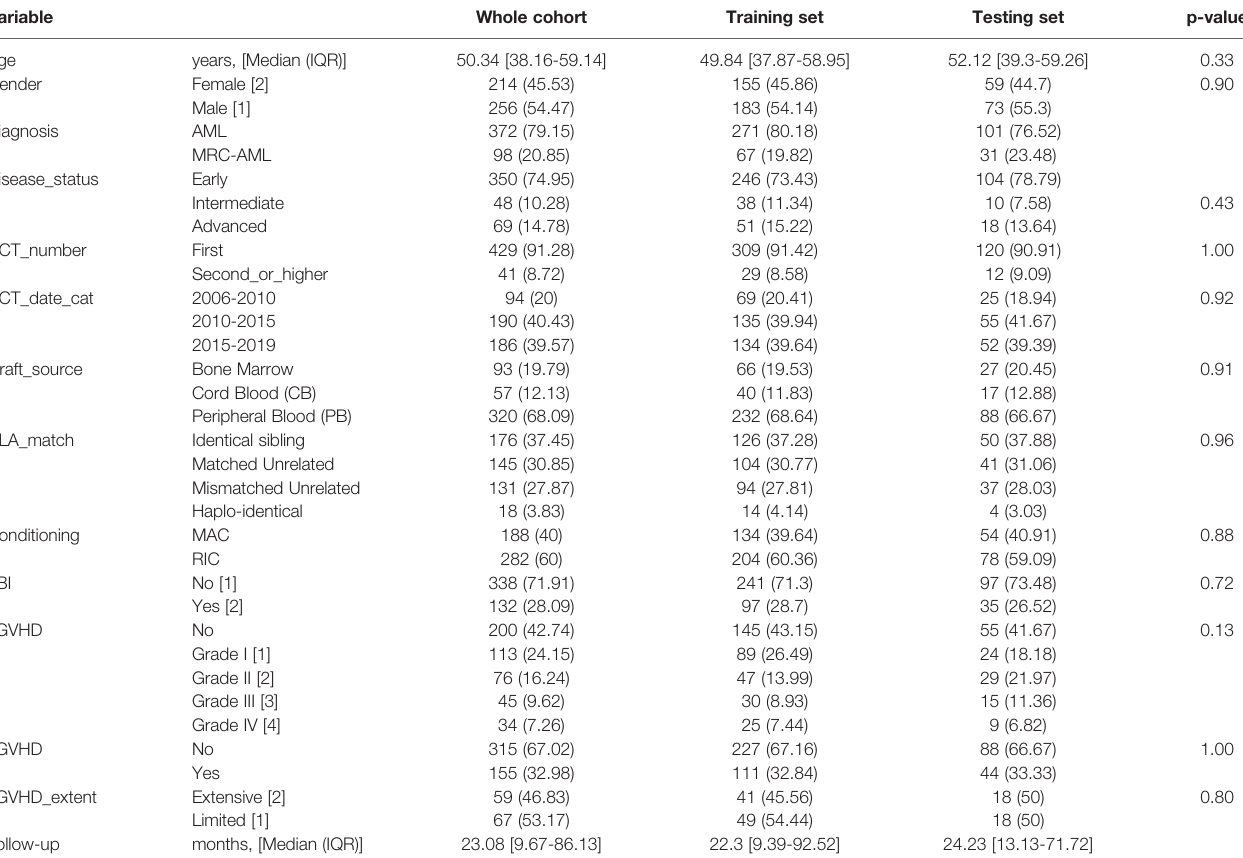
TABLE 1 | AML patient ’ s baseline